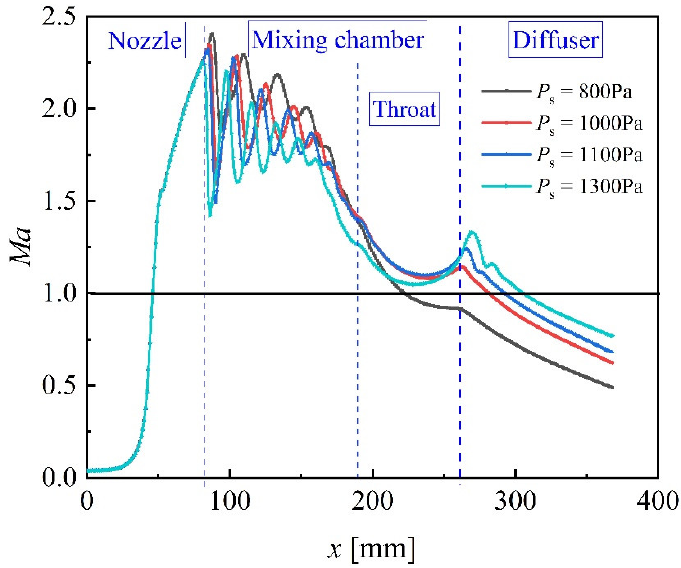
Figure 11. Ma profiles of the axis with different P s .